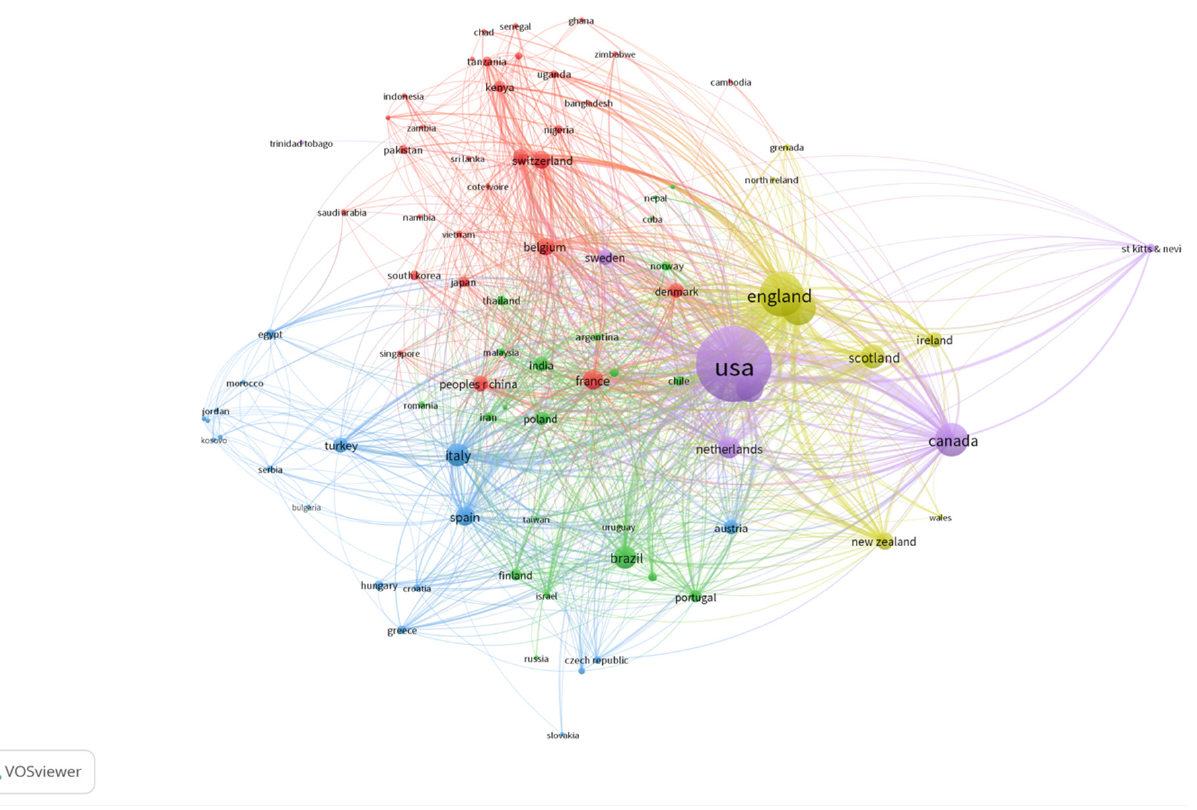
Figure 2. Country collaboration analysis of 6006 veterinary education publications (VEPs) from 2000 to 2021.